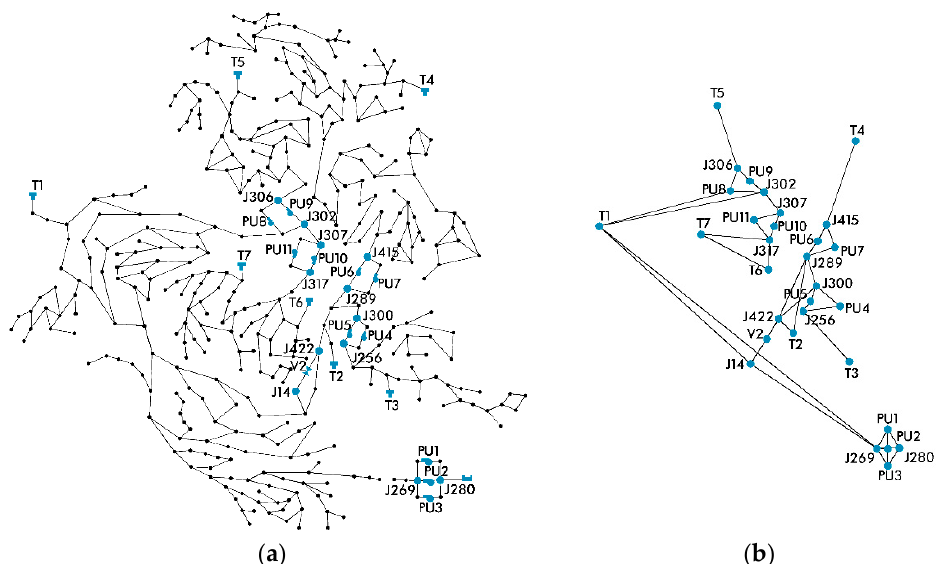
Figure 4. ( a ) The network of C-Town, ( b ) the resulting condensed graph of the network, created based on the available measurements.